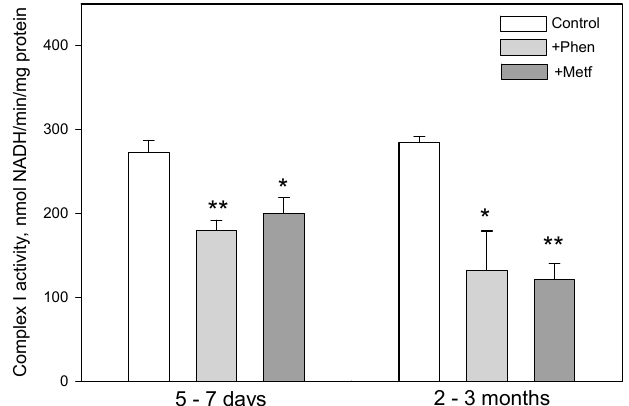
Figure 5. Effect of phenformin and metformin on Complex I activity of brain mitochondria isolated from 5–7 days and 2–3 months age rats. Complex I activity was evaluated by following NADH oxidation rate in isolated freeze–thawed brain mitochondria without (control) or with biguanides—phenformin (Phen, 0.025 mM) or metformin (Metf, 0.5 mM) as described in Methods. Statistically significant difference compared with control group: *— p ≤ 0.05, **— p ≤ 0.01 (n = 3).